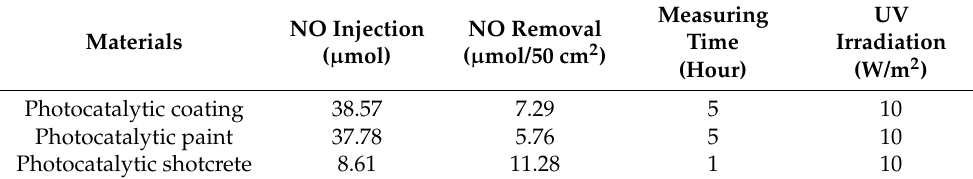
Table 3. Photoreactor test results for NO removal rate at the preliminary test.